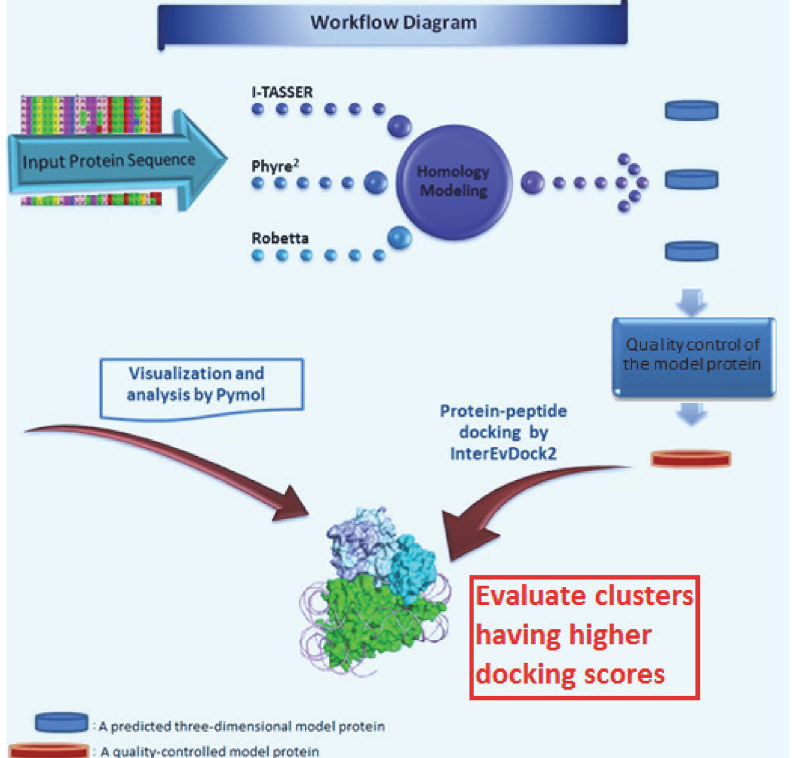
Figure 1. A pipeline of molecular docking of Aggregatin and Amyloid-beta(Aβ) peptide. There are four key steps in the pipeline. First, the prediction of the 3D structure of Aggregatin. Second, the model protein structure analysis for quality. Third, protein-peptide docking by the InterEvDock2 server. Forth, the final analysis by the PyMOL software.